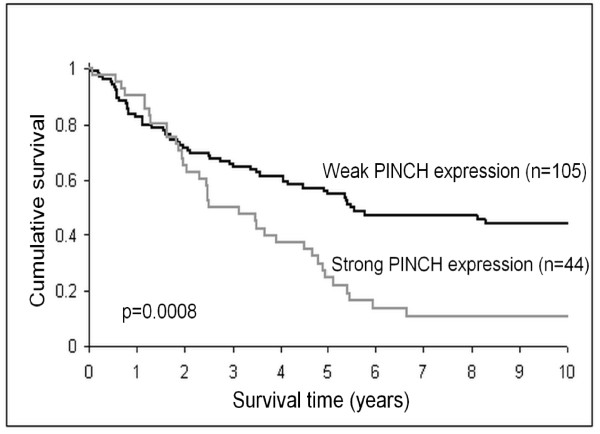
PINCH expression in adjacent normal mucosa in relation to patient survival. Strong expression of PINCH in adjacent normal mucosa is significantly related to worse survival (p = 0.0008).